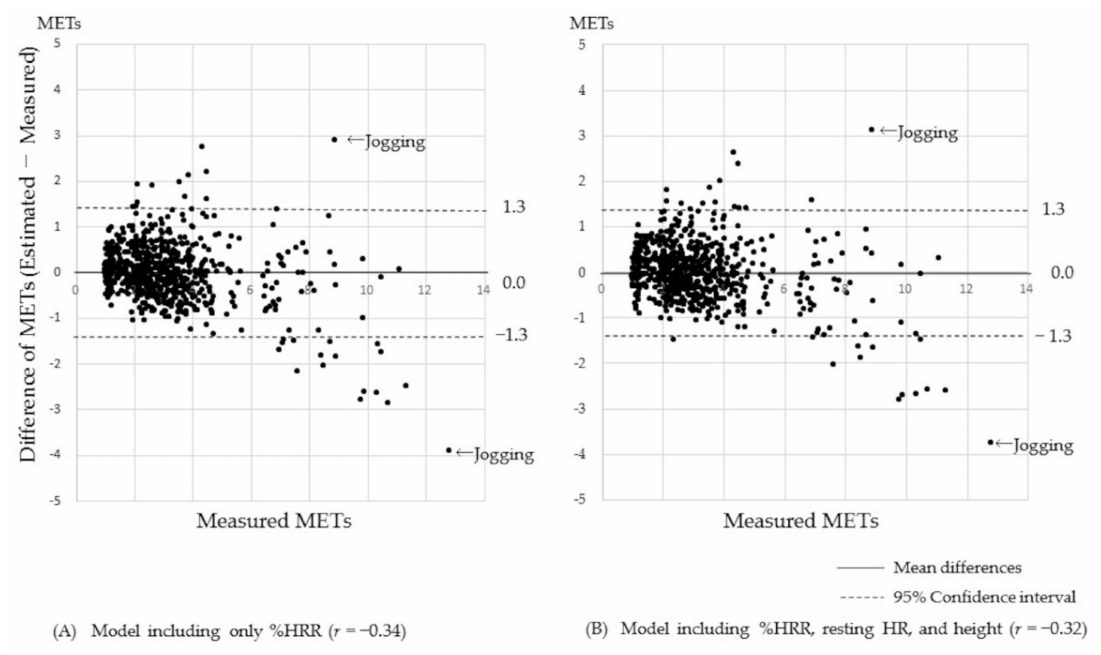
Figure 3. Di ff erences between measured and estimated METs by Bland–Altman analysis (N = 40, 673